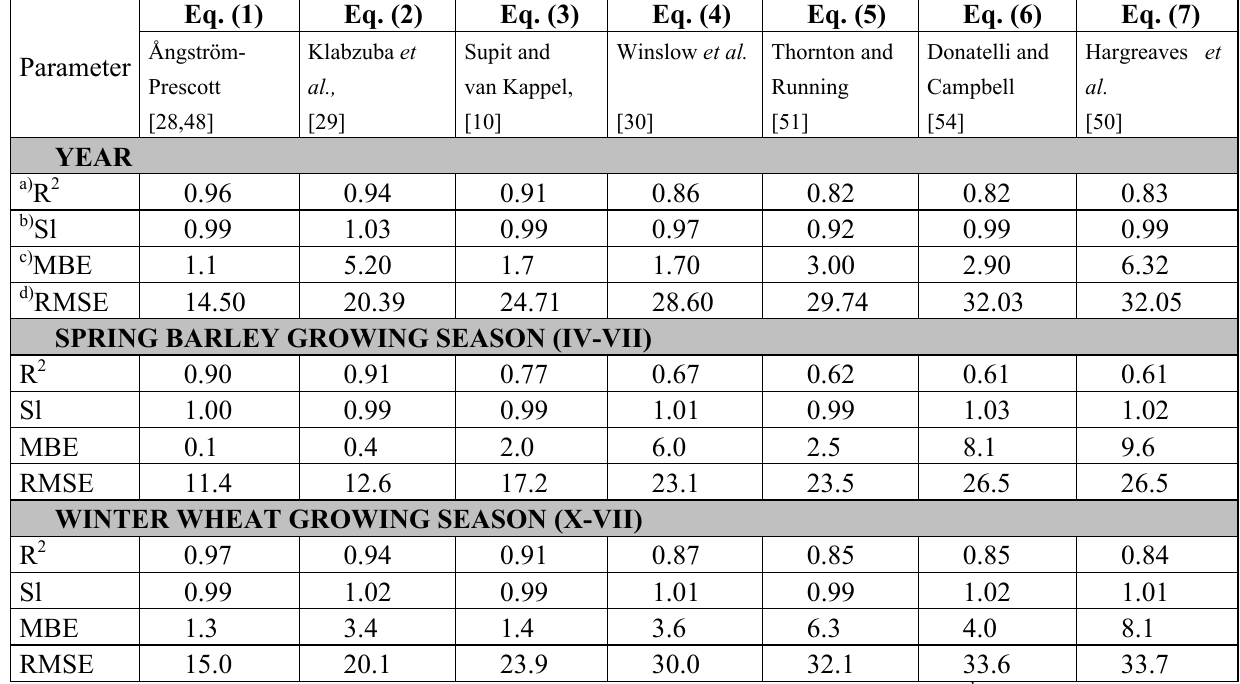
Table 1. Summary of performance of various methods of R using regression coefficients, annual G mean bias error (MBE) and annual root mean square error (RMSE). The results are based on the pooled data from the 8 observational sites with total 97 complete years of